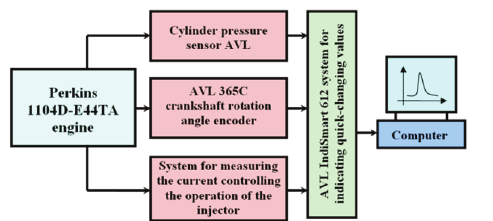
Fig. 3. The flow chart of the measurement system of fast-changing quanti- ties of Perkins 1104D-E44TA engine used for